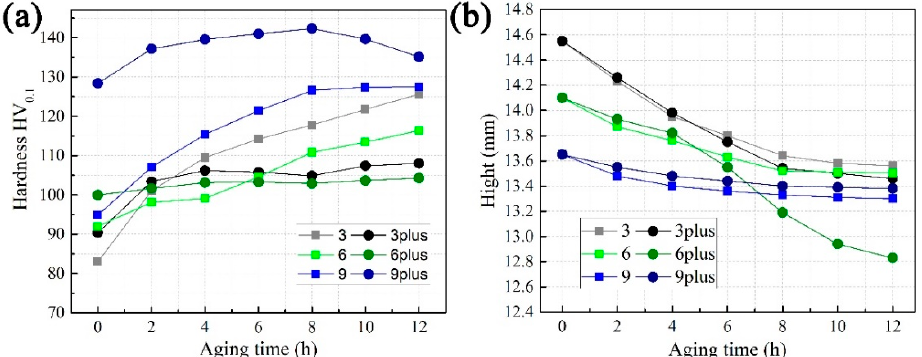
Figure 3. Variation of hardness ( a ) or height ( b ) as the function of compressive creep aging time.